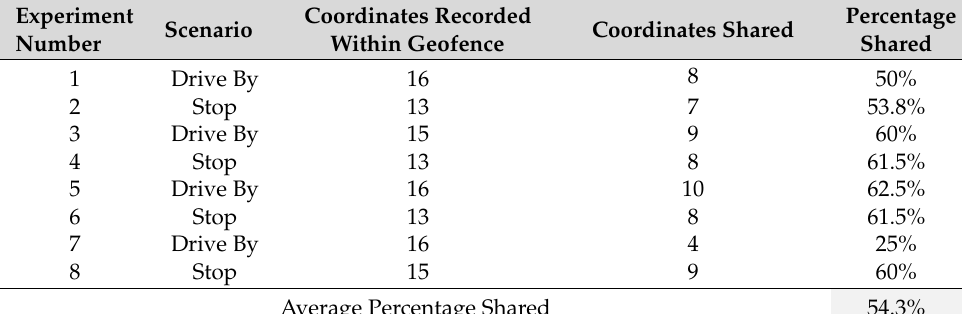
Table 7. Percentage of Coordinates Collected Shared with Base Station During